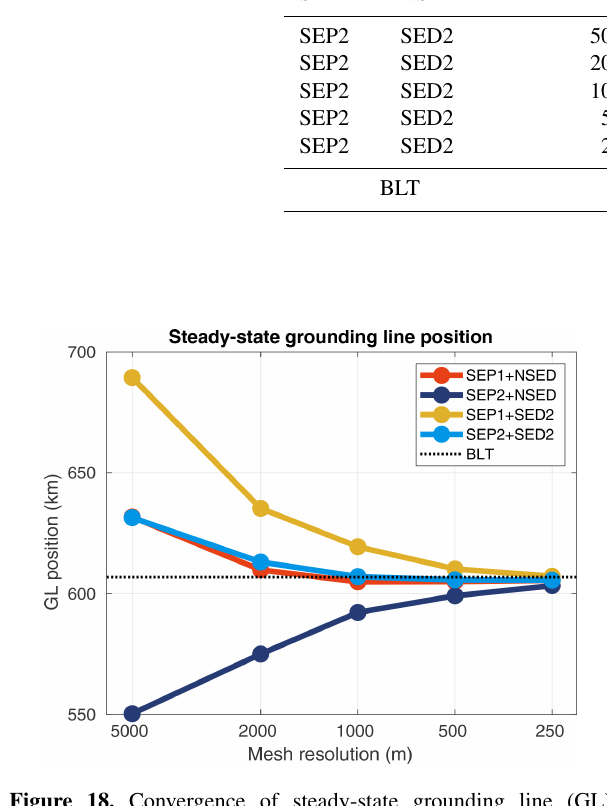
Figure 18. Convergence of steady-state grounding line (GL) positions ( y = 0km) for the MISMIP3d setup. Different sets of sub-element parameterizations are tested: SEP1 + NSED, SEP2 + NSED, SEP1 + SED2, and SEP2 + SED2. The dotted line is the grounding position from the boundary layer theory (BLT) (Schoof,